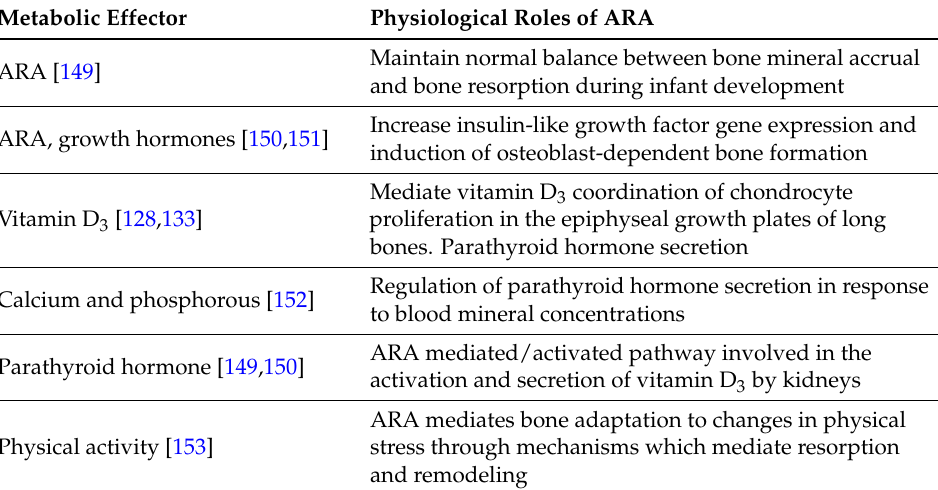
Table 3. Roles of ARA in bone formation, metabolism, and mineral